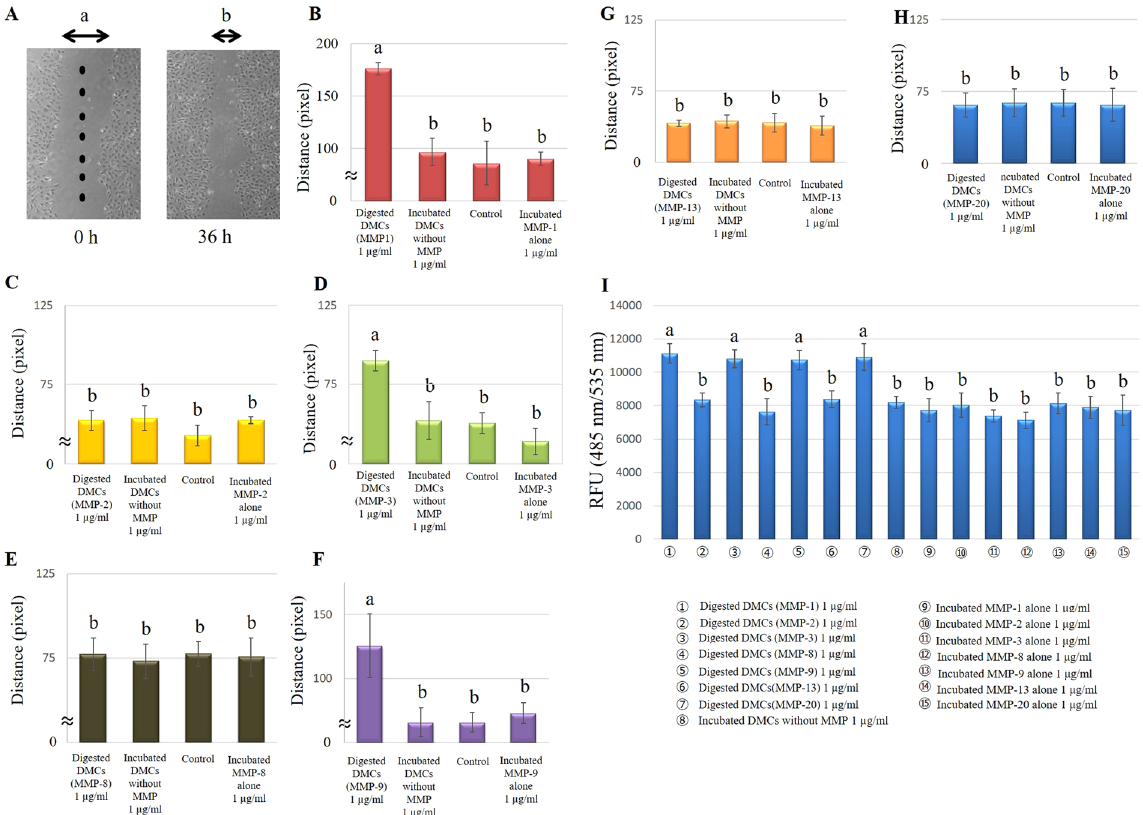
Figure 3. Effects of 1 µ g/ml of dentin matrix components (DMCs) treated with matrix metalloproteinases (MMPs) on wound scratch ( B–H ) and chemotactic ( I ) cell migration. Eight points were randomly selected to assess wound scratch migration; the distances of the cells from the edge of the scratch wound were measured by microscopic observation ( A ). Wound scratch migration of cells incubated with 1 µ g/ml DMCs treated with MMP-1 ( B ), MMP-2 ( C ), MMP-3 ( D ), MMP-8 ( E ), MMP-9 ( F ), MMP-13 ( G ) and MMP-20 ( H ) is presented as the amount of movement, and chemotactic migration of cells incubated with 1 µ g/ml DMCs treated with MMP-1, MMP-2, -3, -8, -9, -13, and -20 is presented as relative fluorescence units (RFU) (I). One microgram per millilitre of DMCs treated with MMP-1, -3, or -9 promoted horizontal migration, compared with 1 µ g/ml of incubated DMCs without the addition of MMPs (p < 0.05). The trans-well assay demonstrated the